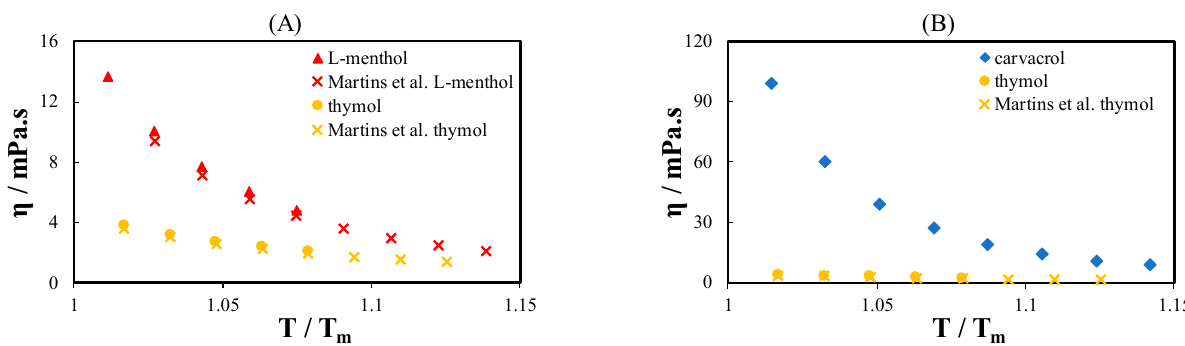
Figure 2. ( A ) Viscosity of L -menthol and thymol and ( B ) viscosity of thymol and carvacrol as a function of temperature normalized to the melting temperature of the pure terpenes. Filled symbols are data measured in this work, and cross symbols are data in the literature from Martins et al. [32].